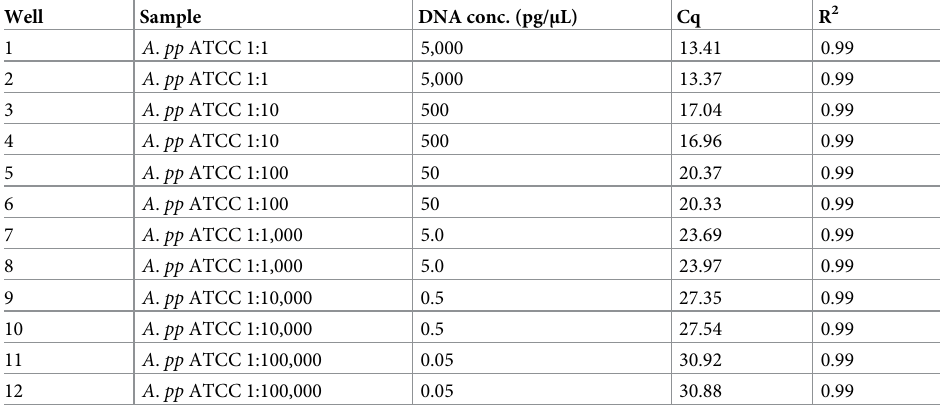
Table 1. Cq values of A . pleuropneumoniae (A . pp) ATCC 20790 DNA serial dilutions. Well Sample DNA conc. (pg/ μ L) Cq R